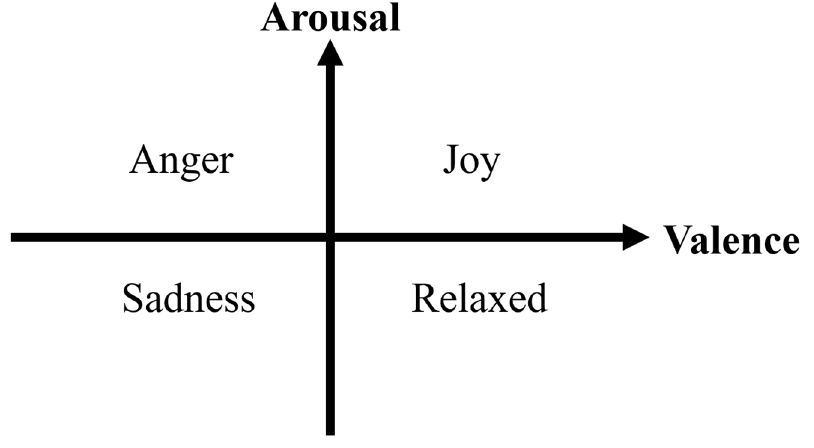
Figure 1. Arousal and valence